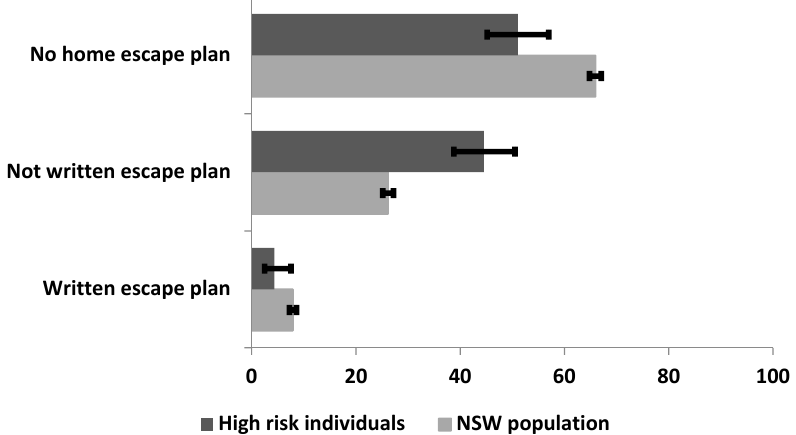
Figure 2. Prevalence of not possession of a home escape plan, not having a written home escape plan and having a home escape plan in NSW.